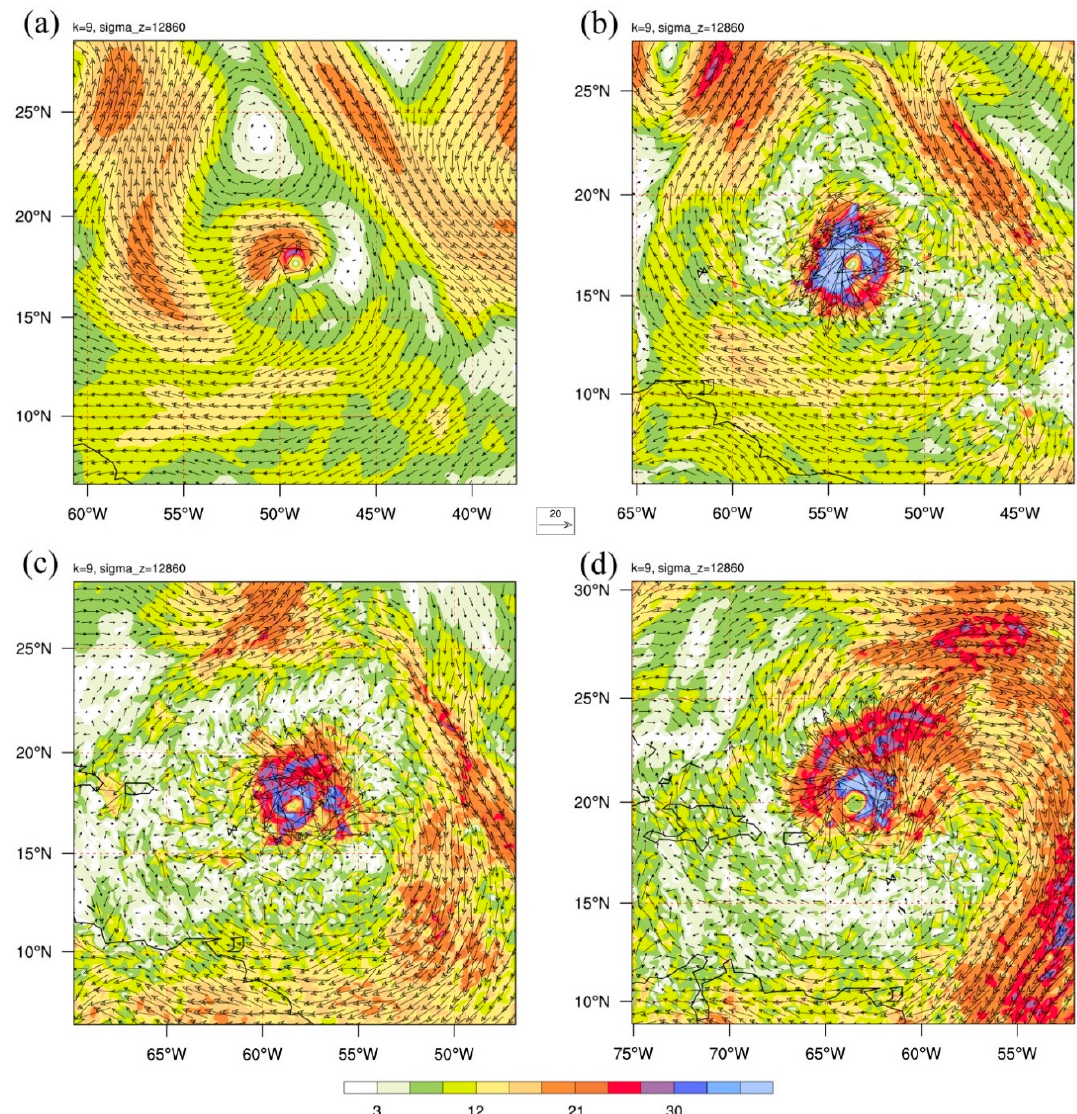
Figure 12. As in Figure 11, except from ( a ) cold-start COAMPS-TC initial conditions (tau = 0 h) at 1800 UTC 3 September as in Figure 8b, and then COAMPS-TC forecasts at ( b ) tau + 24 h, ( c ) tau + 48 h, and ( d ) tau + 72 h.